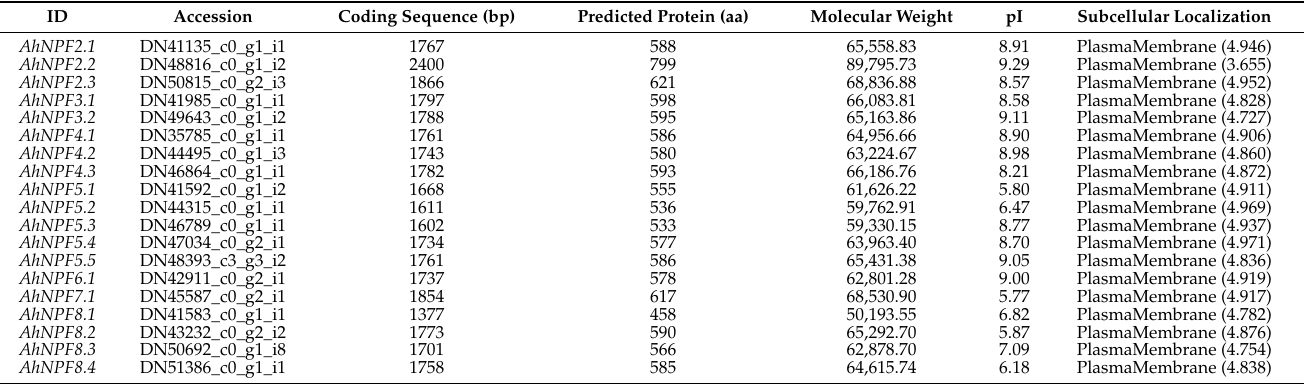
Table 1. Gene ID, accession, coding sequence length, molecular weight, theoretical isoelectric point (pI) and subcellular localization of agave NPFs